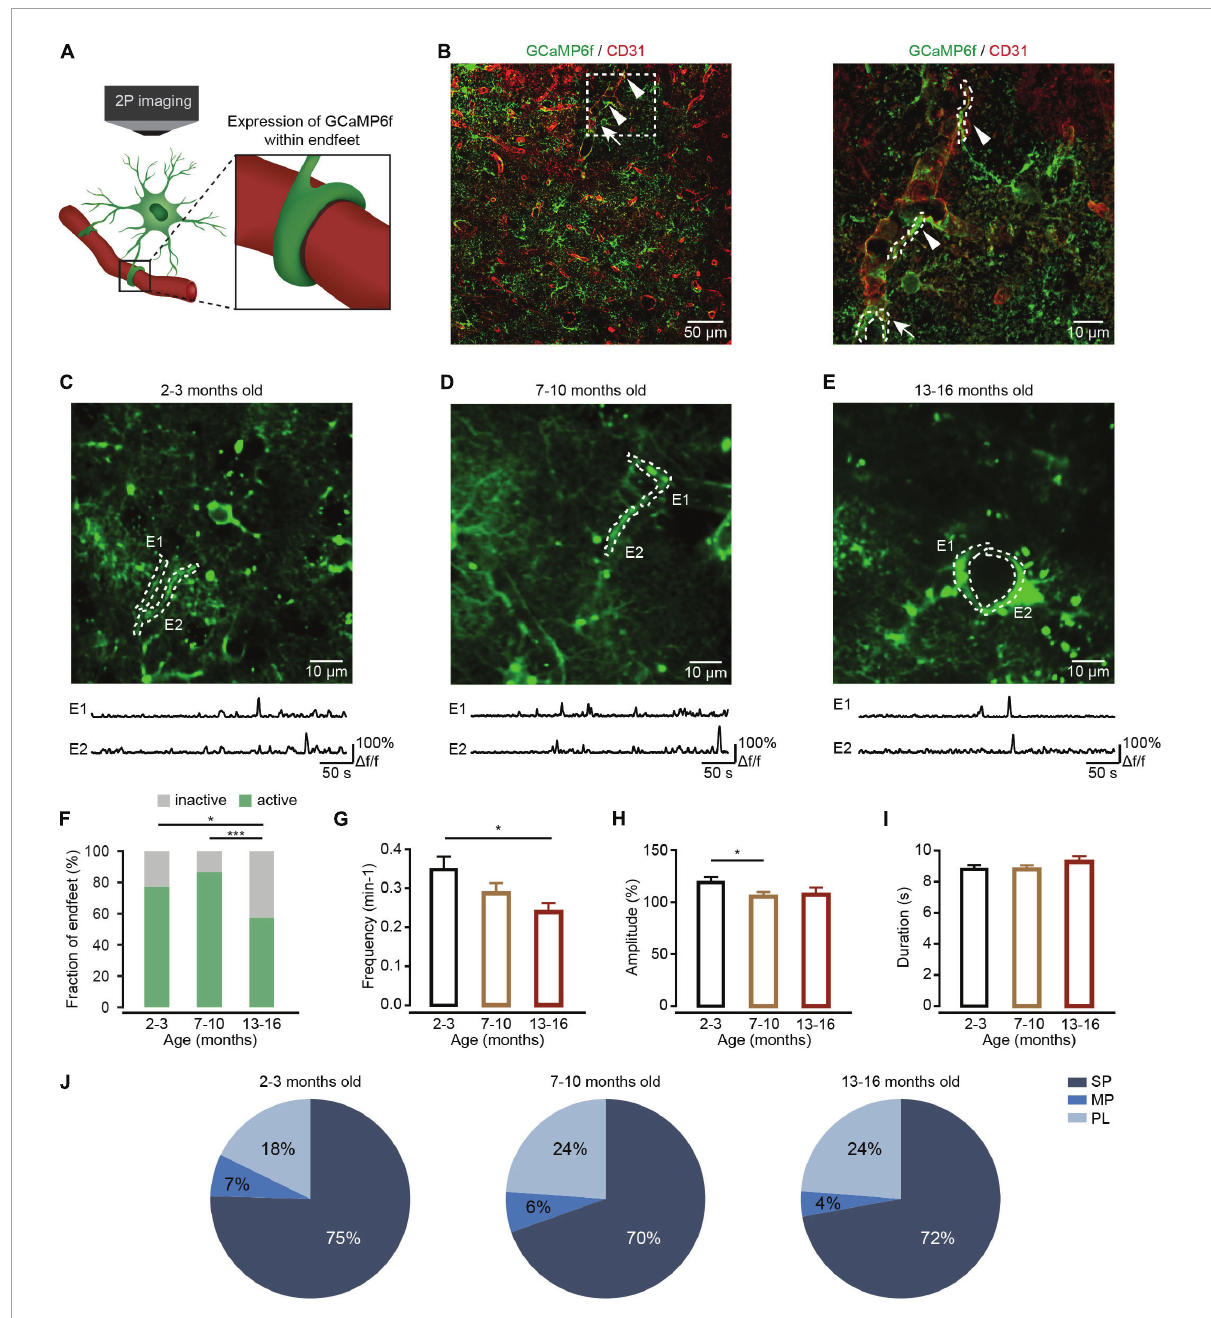
FIGURE3 Ca 2 + transient changes within endfeet of cortical astrocytes during brain aging. (A) Schematic of two-photon Ca 2 + imaging of astrocytic endfeet expressing GCaMP6f. (B) Left, a representative image showing GCaMP6f (green)-labeled astrocytes and CD31 (red)-labeled blood vessels in the cortices of mice 4 weeks after AAV5-GfaABC 1 D-cytoGCaMP6f-SV40 injection. Right, a high-magnification image showing immunostaining of GCaMP6f (green) and CD31 (red) as indicated by the white-dashed box in the left panel. The arrowheads point to the sagittal sections of the endfeet. The arrow points to the coronal sections of the endfeet. (C–E) Top, representative two-photon images of GCaMP6f-labeled endfeet ROIs in the 2–3-month-old ( C ; imaging depth, 155 µ m), 7–10-month-old ( D ; imaging depth, 107 µ m), and 13–16-month-old groups ( E ; imaging depth, 113 µ m). Endfeet are outlined by a white-dashed line. Below are example traces of spontaneous Ca 2 + transients from each ROI. (F) The fraction of active endfeet within the 2–3-month-old ( n = 79 ROIs from seven mice), 7–10-month-old ( n = 89 ROIs from seven mice), and 13–16-month-old groups ( n = 89 ROIs from seven mice). All groups: χ 2 = 20.3088, P = 3.89 × 10 - 5 ; the 2–3 month-old group versus the 7–10-month-old group: P = 0.3484; the 2–3 month-old group versus the 13–16-month-old